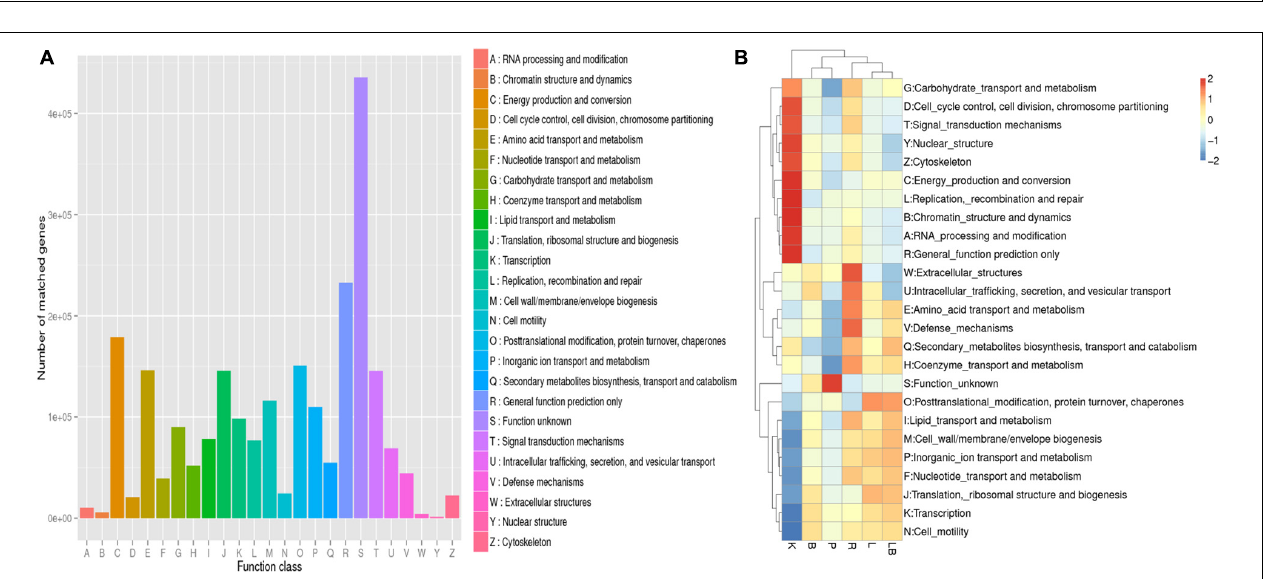
FIGURE 2 | Analysis of the active microbiome in freshwater benthic biofilms subjected to different RNA extraction methods. (A) EggNOG level 1 relative abundance of biofilm communities at the gene expression level for each extraction group. (B) Heat map depicting the 35 most dominant phyla at the gene expression level. Abbreviations of extraction groups denote, K: Column-based kit isolation; R: RNAzol only group; B: Bead-beating group; L: Lysozyme group; P: Cell disruption bomb; LB: Lysozyme + Bead-beating group.